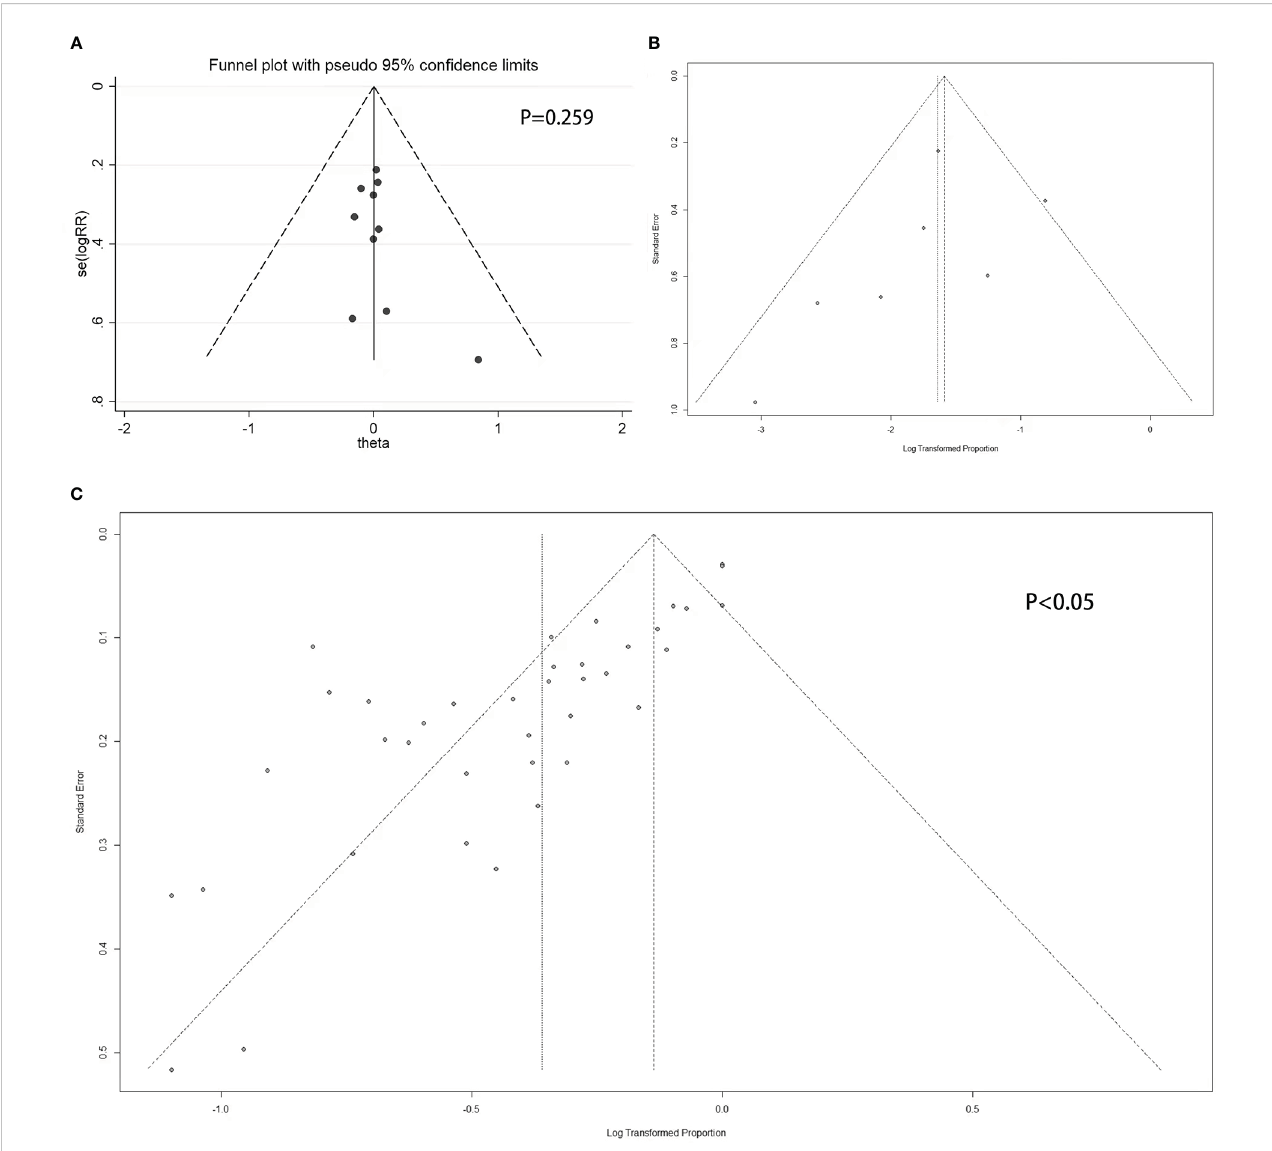
FIGURE 4 Funnel plot. (A) Double-armed studies; (B) Single-armed studies related to prolactinoma treatment; (C) Single-armed studies related to hyperprolactinemia